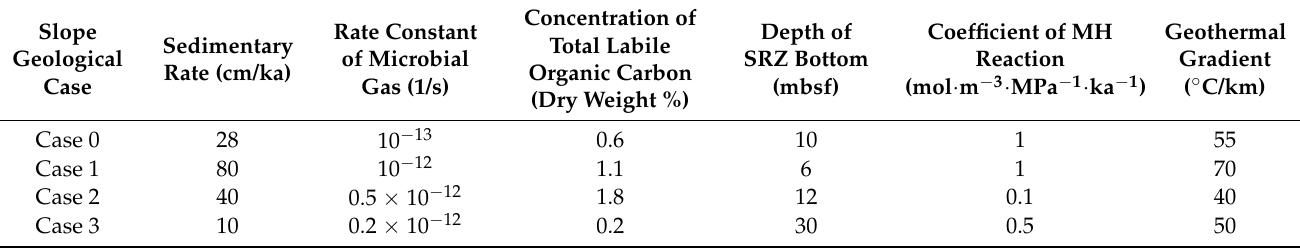
Table 1. Four designed geological scenarios for microbial methane generation that may occur in Dongsha